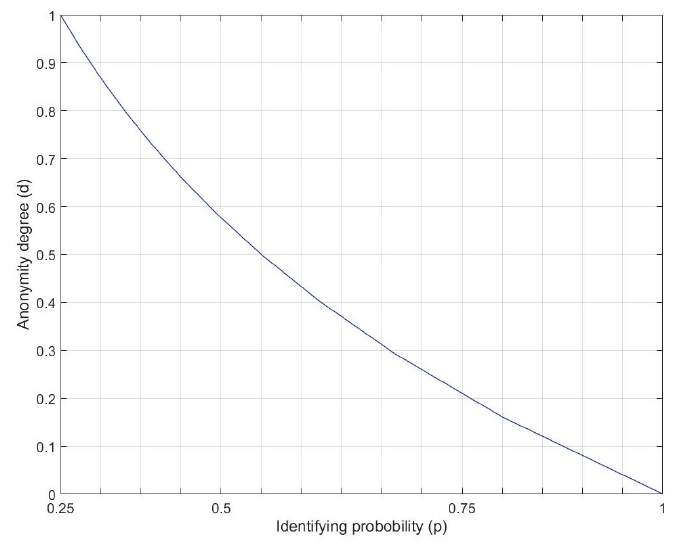
Figure 8. Anonymity degree curve for anonymity set in Table